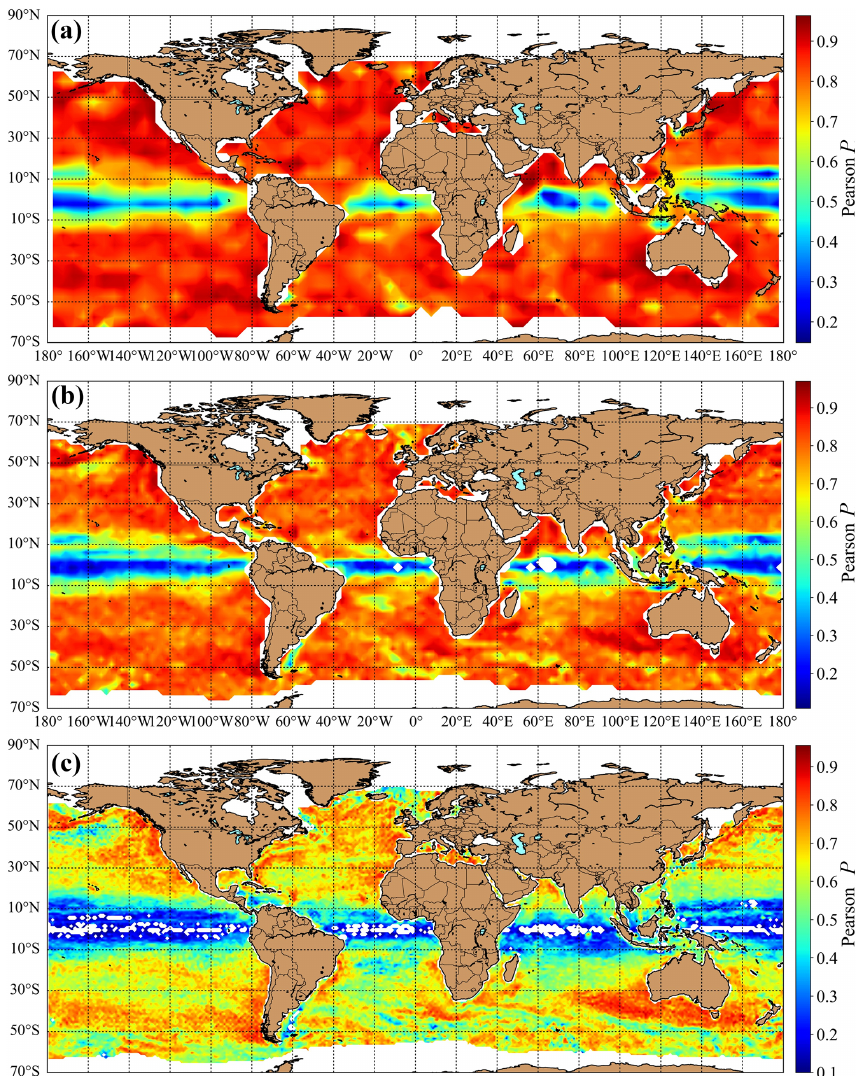
Figure 2. Pearson correlation coefficients P for the integrated kinetic energy I EKE (t) and enstrophy I Z (t) at three different tilings determined for the whole period of AVISO records. (a) 21 × 21 grid cells; (b) 11 × 11 grid cells; (c) 5 × 5 grid cells (for details see Sect.